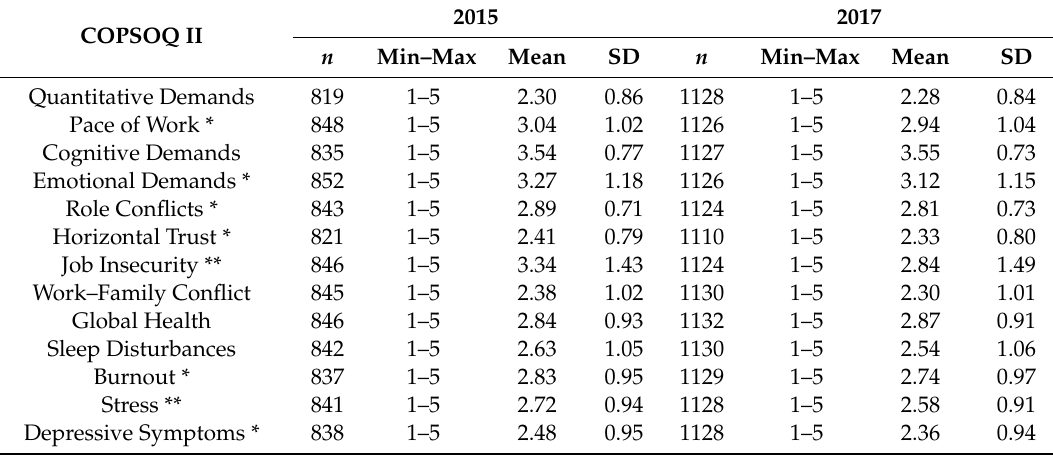
Table 5. Psychosocial factors among study participants in 2015 and 2017—COPSOQ II scales for which the higher value are unfavorable.